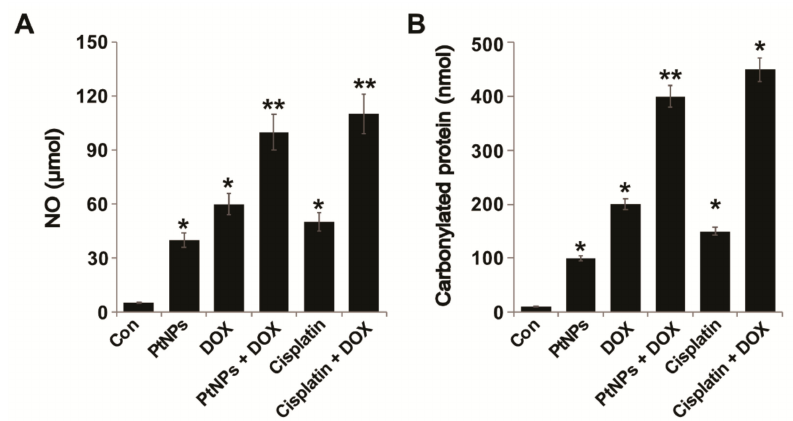
Figure 9. PtNPs and DOX increase the NO and protein carbonyl content of U2OS cells. U2OS cells were treated with PtNPs (10 µ g / mL), DOX (1 µ g / mL), CIS (5 µ g / mL), or a combination of PtNPs (10 µ g / mL) and DOX (1 µ g / mL) or combination of DOX (1 µ g / mL) and CIS (5 µ g / mL) for 24 h. ( A ) NO production was quantified spectrophotometrically using Griess reagent and expressed as micromoles. ( B ) Protein carbonyl content was measured and expressed as nanomoles. Di ff erences between the treated and control groups were measured using Student’s t -test and statistically significant di ff erences are indicated by * ( p < 0.05). The results are presented as mean ± standard deviation of three experiments. * p < 0.05 was considered significant; ** p < 0.01 was considered highly significant and *** p < 0.001 was considered very highly